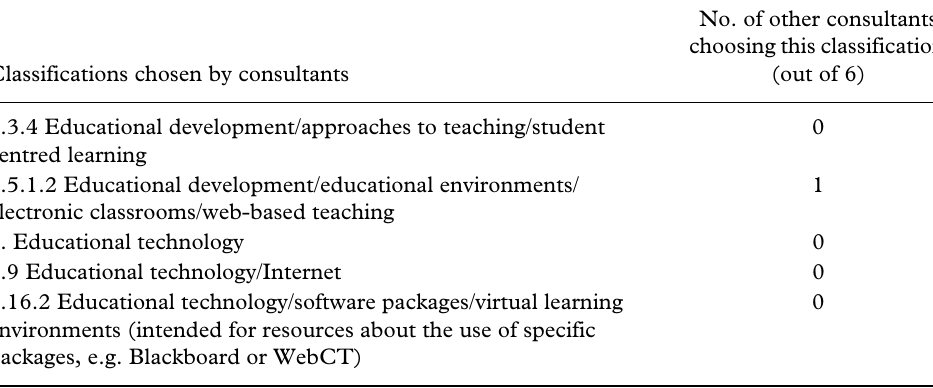
Classifications chosen by